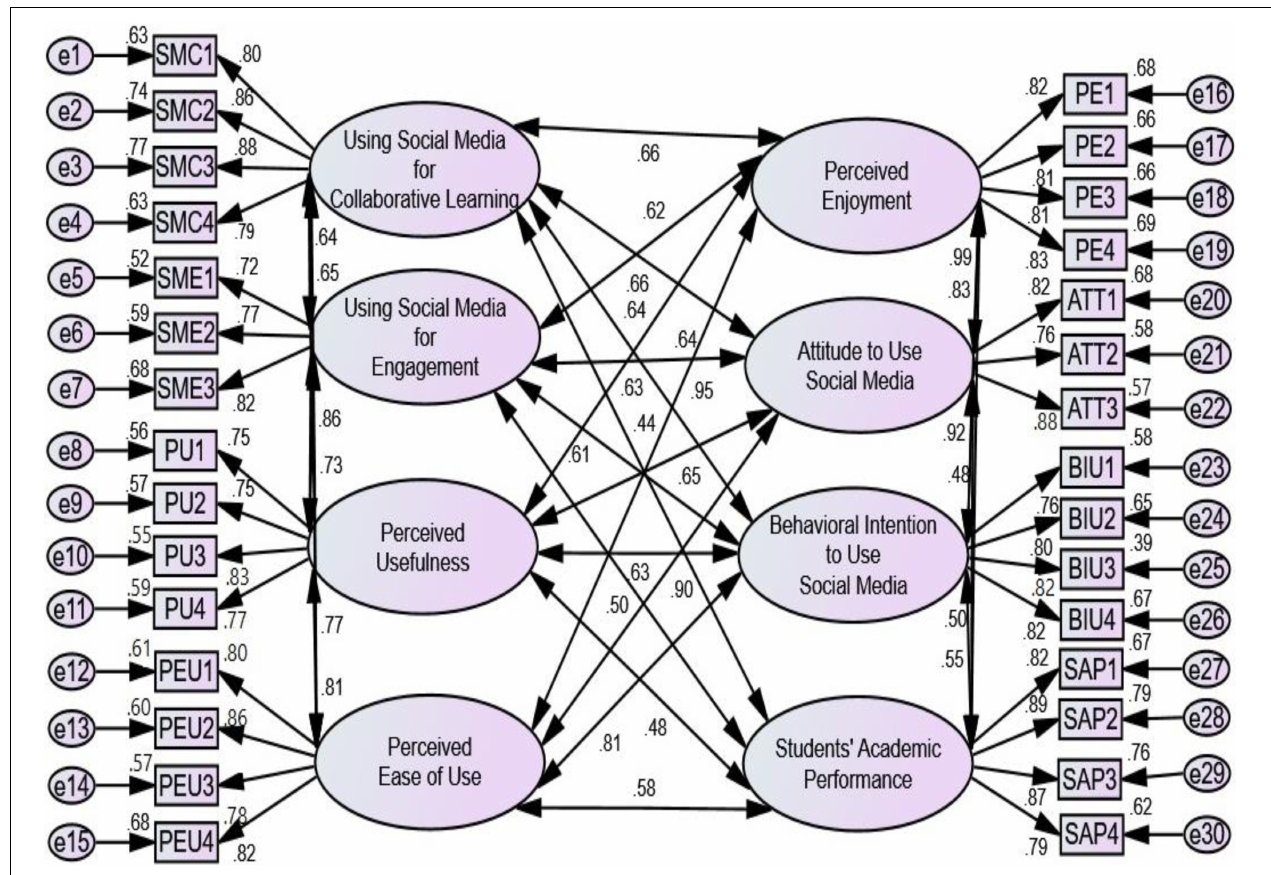
FIGURE 2 | Measurement